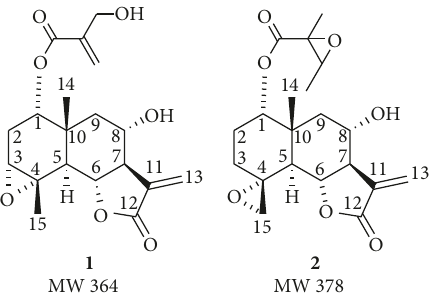
Figure 1: Structure of the eudesmanolides 1 and 2